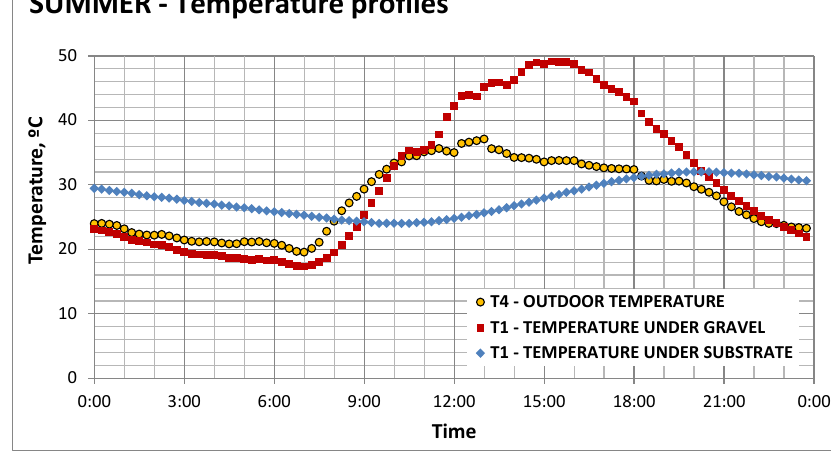
Figure 9. Temperature evolution for a typical summer day with and w/o green roof.